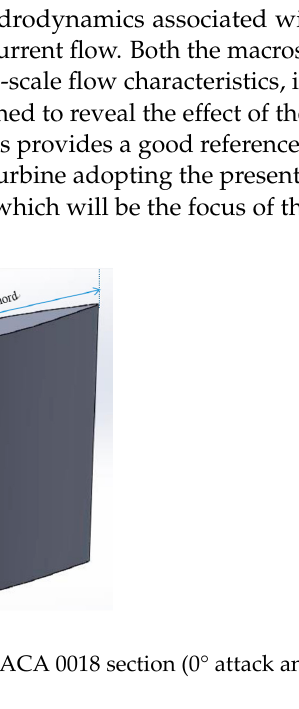
Figure 1. Sketch of the base blade.